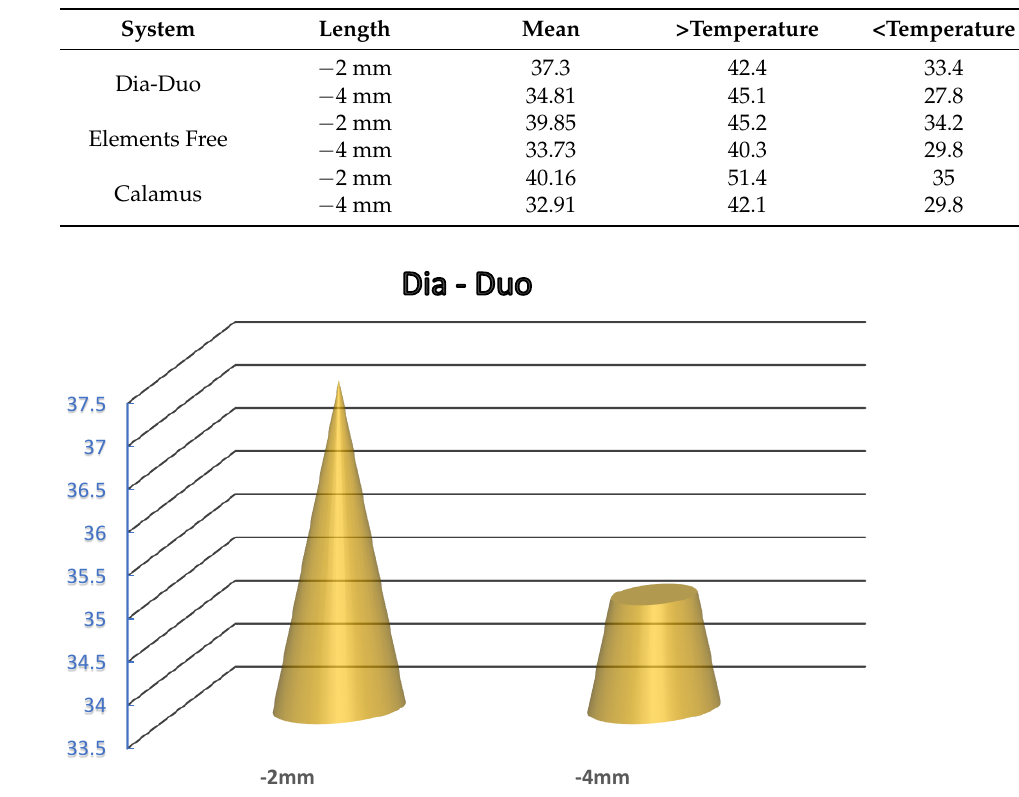
Table 2. System averages based on their sealing depth and minimum and maximum temperature values.